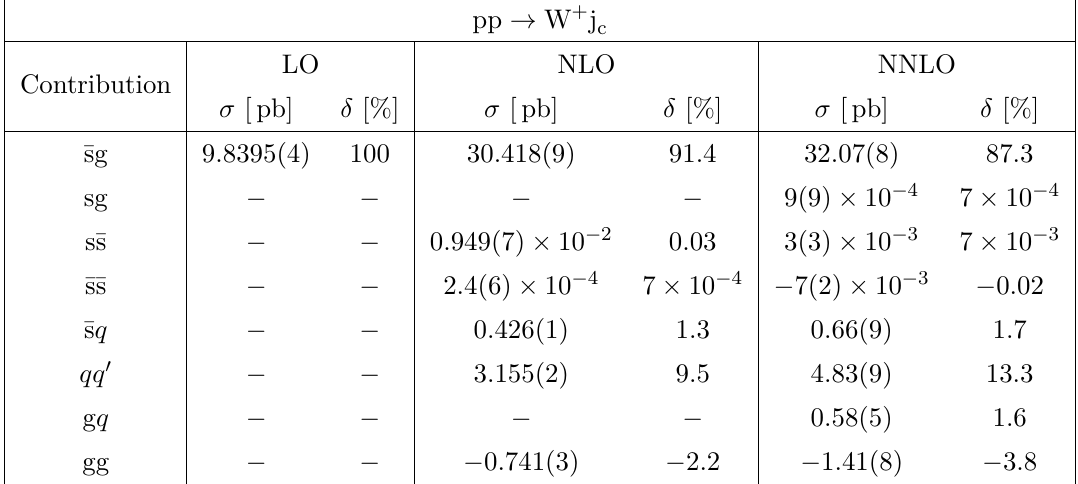
Table 5. Cross-section contributions according to the initial state at LO, NLO, and NNLO QCD √ for pp → W + j at the LHC at s = 7 TeV. Both the absolute (in pb) and the relative contributions c (in per cent) are indicated. Any quark or anti-quark that is not a strange or anti-strange quark is denoted by q or q 0 . The digit in parenthesis indicates the Monte Carlo statistical error. The theoretical predictions are obtained for V = 0 . cd